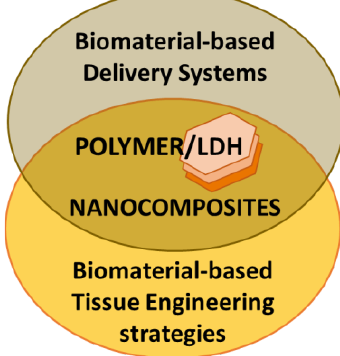
Figure 2. Biomaterials-based nanocomposites focused on this work: 2D nanomaterials and organic